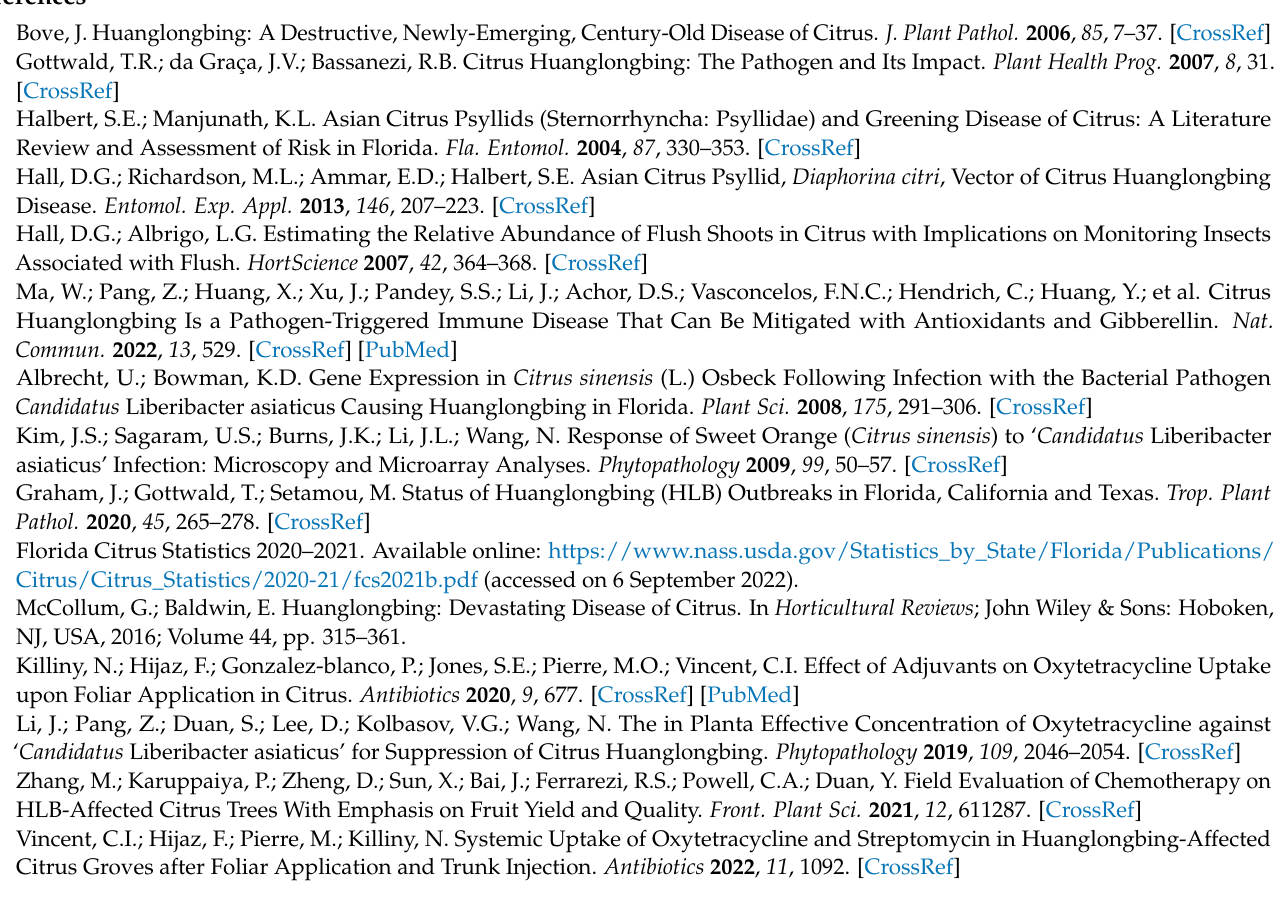
ratings; Figure S2: Fruit from the 2020/21 production season; Figure S3: Fruit from the 2021/22 production season; Figure S4: Phenotype of trees five months after the first injection; Figure S5: Phenotype of trees 12 months after the first